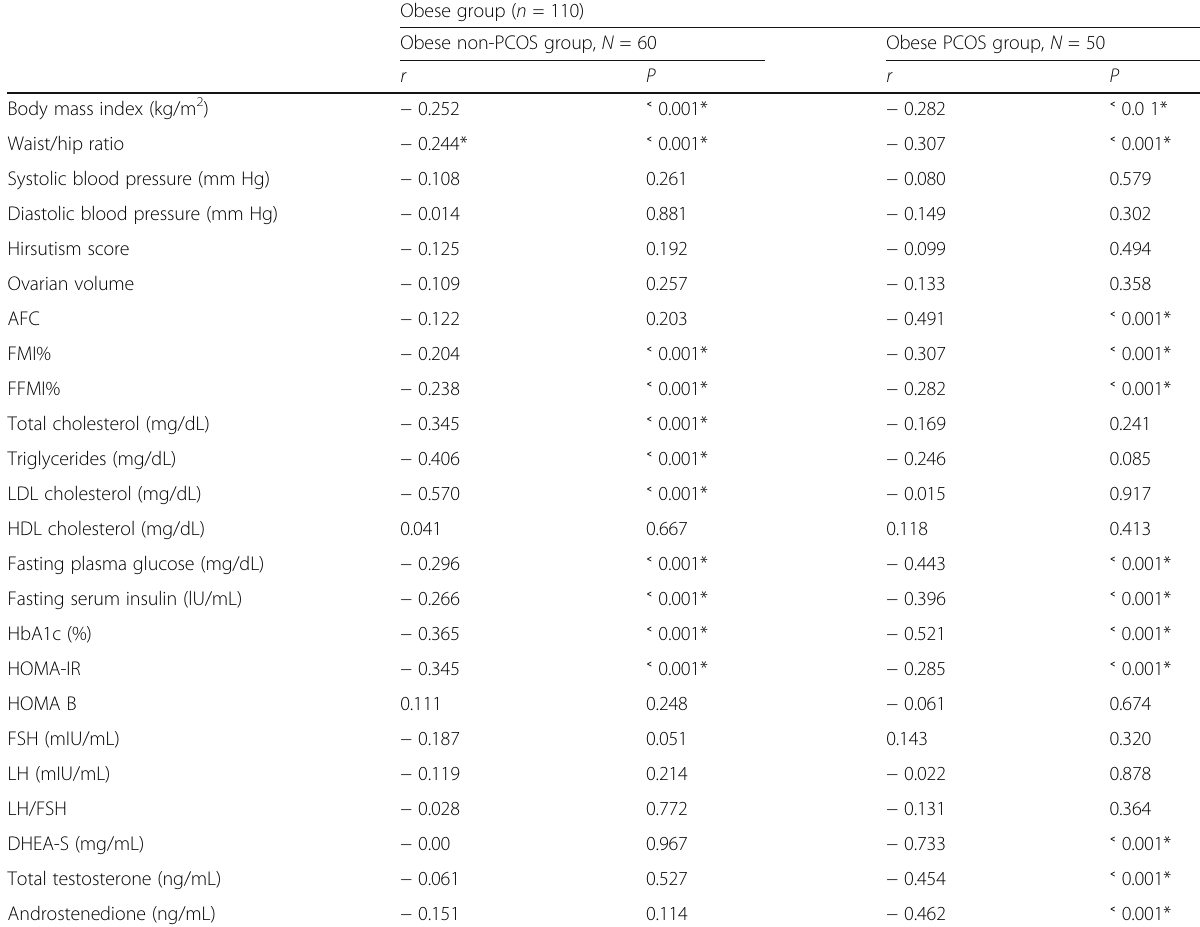
Table 4 Pearson correlation coefficient between plasma ghrelin (ng/ml) with clinical, anthropometric, laboratory, and phenotype characteristics of obese